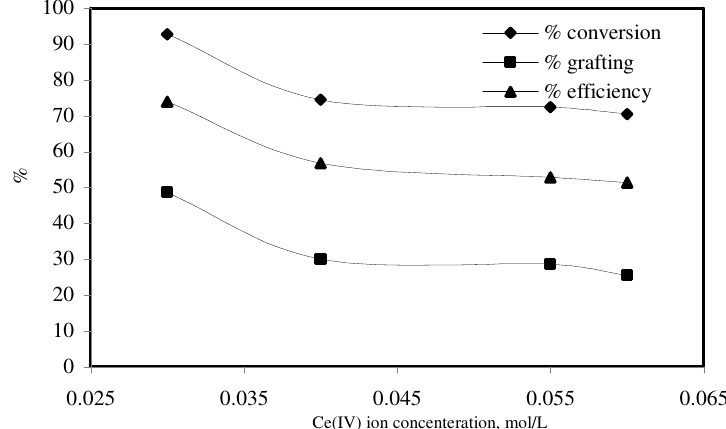
Figure 5. Influence of concentration of the ceric ion on the grafting of bleached